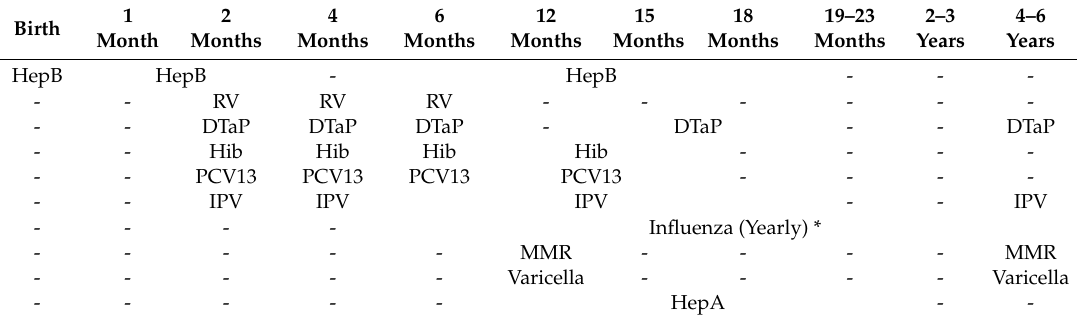
Table 2. Recommended vaccinations for infants and children (birth through 6 years) reproduced from the CDC